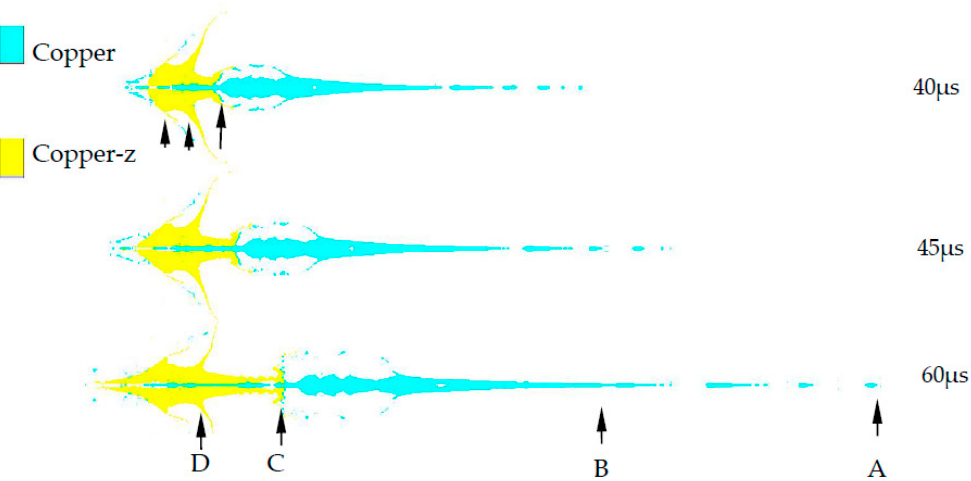
Figure 7. Jet morphology of charge without shell. “A, B, C, D” is the reference position.